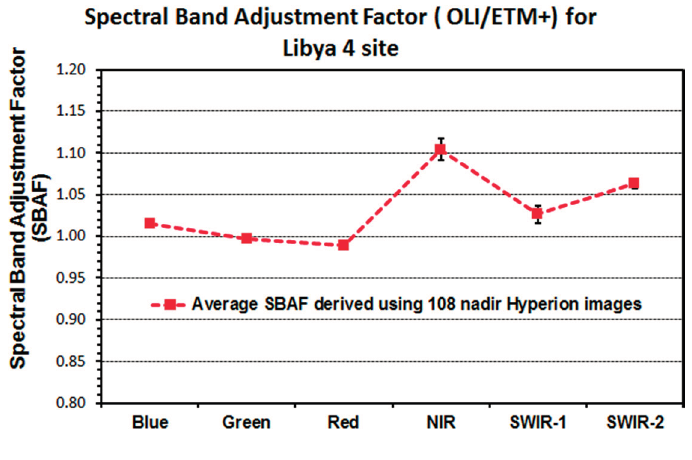
Figure 5. Spectral band adjustment Factor (SBAF) for Libya 4 test